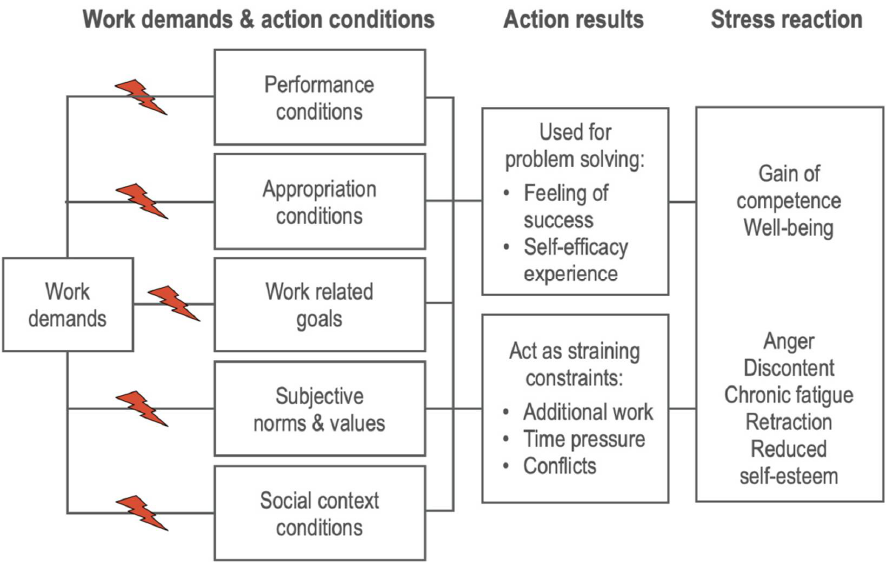
Figure 2. A relational resource-based stress generation model